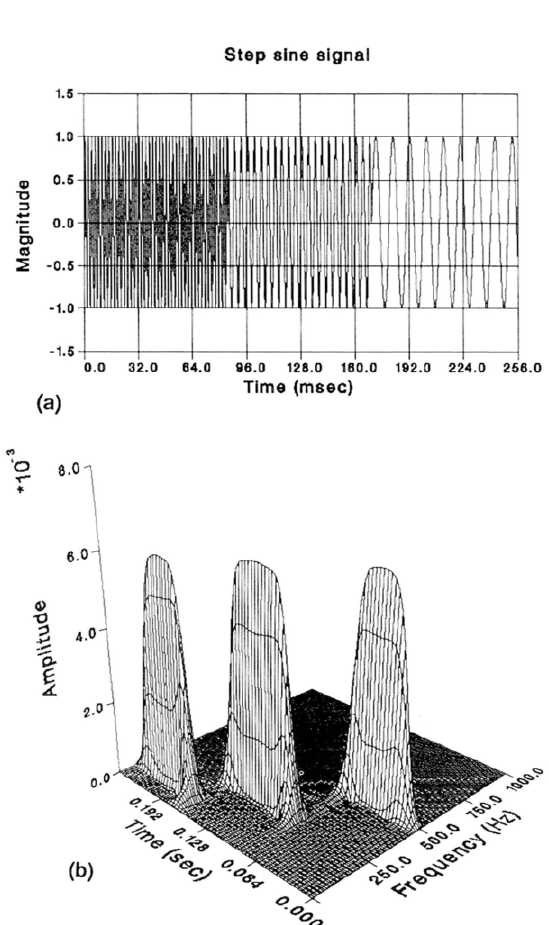
FIGURE 4 Sine wave with stepwise frequency changes: 100,250, and 500 Hz.!s = 2000 Hz, N = 512, and smoothing windows size = 10 x